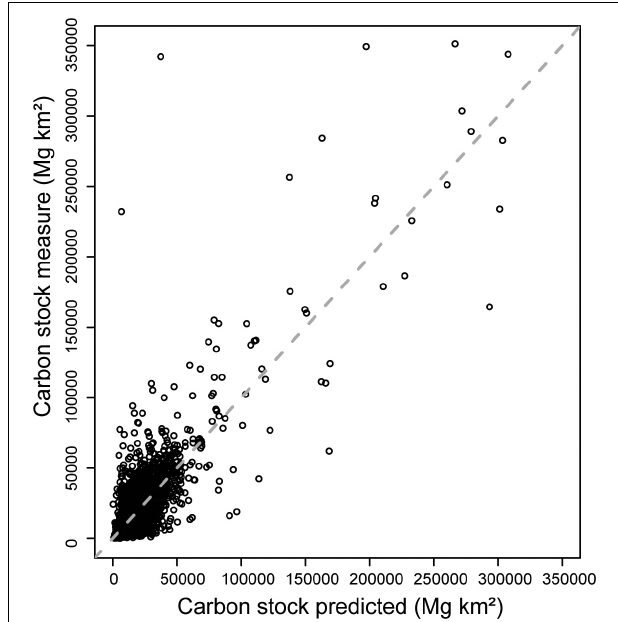
FIGURE 3 | Predicted carbon (C) stock data versus measured C stock. Each data point represents the C stock data from one core. Measured C stocks were calculated from the data reported in the original source study, while predicted C stocks were obtained from the Random Forest model. The dashed line represents the 1:1 line where measured data equals predicted data.